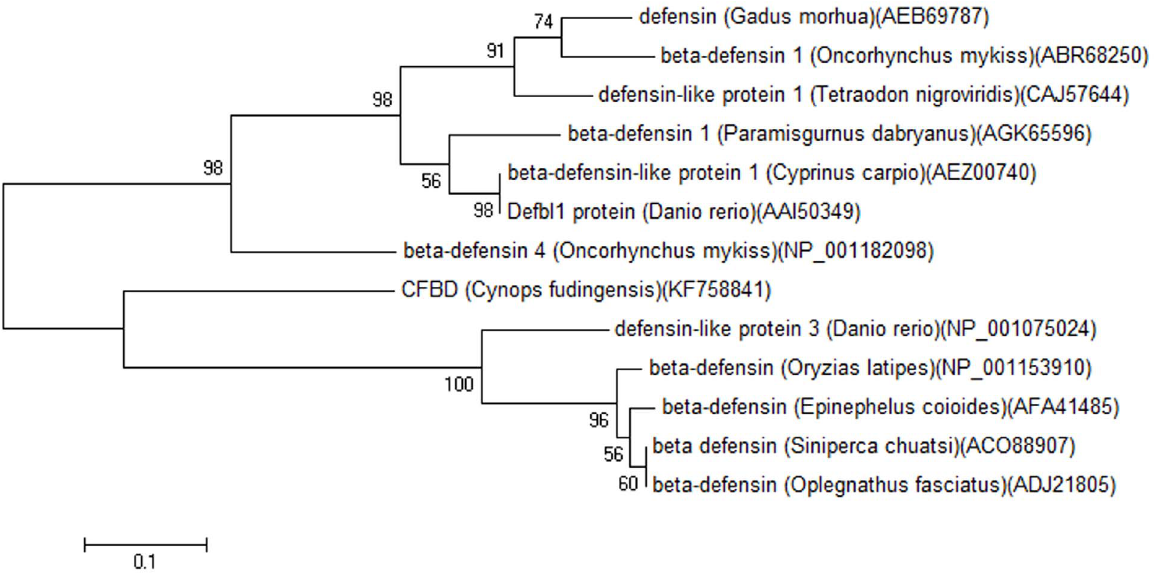
Figure 3. Phylogenetic analysis of CFBD with other b -defensins. Phylogenetic dendrogram obtained by neighbour-joining analysis based on the proportion difference (p-distance) of aligned amino acid of the full-length peptide sequences. All defensin sequences are from NCBI and the sequence ID is listed behind.